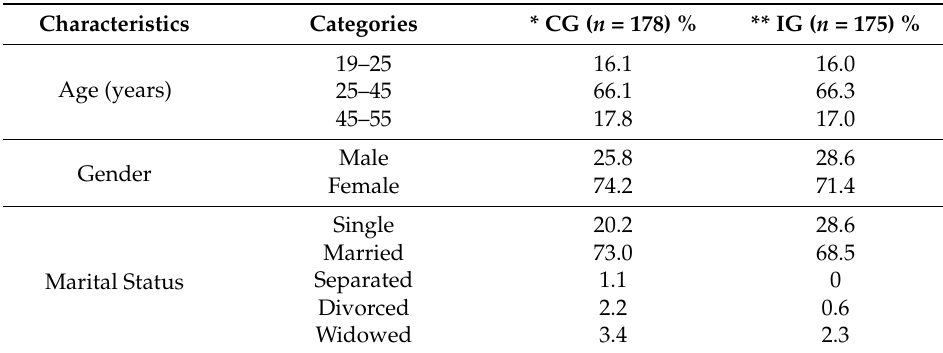
Table 2. Percentage distribution of sample